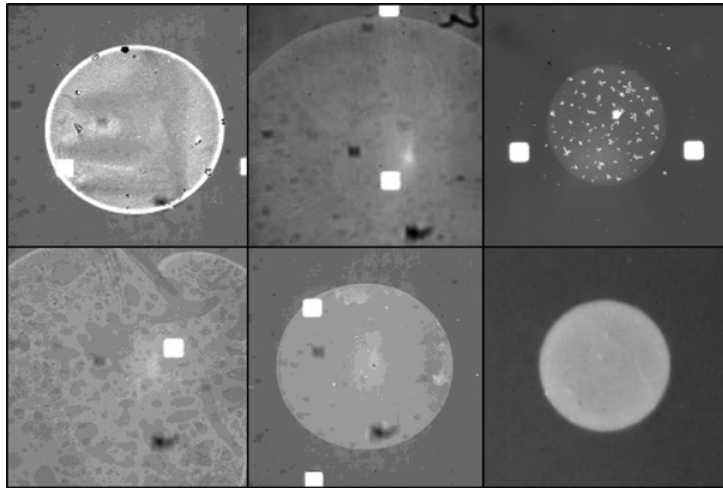
Figure 7: Protein microarray “spots” printed by a microdroplet arrayer can be highly heterogeneous and uneven, which can be a source of noise for label-free detection of BNPs. Depending on the spotting solution contents and the surface material, deposited droplets may dry to form spots with small diffraction-limited islands (top left), striations (top center), multi-scale heterogeneities (bottom left), and isolated regions of high immobilization (bottom center, near the top, and right edges of the spot). They may also accumulate salt deposits (top right). Contrast these poor spots with the one at the bottom right, which is very smooth, uniform, and flat. Developing a virus particle count- ing software that can filter out all of these types of features has been a significant challenge. Shown regions are 200 × 200